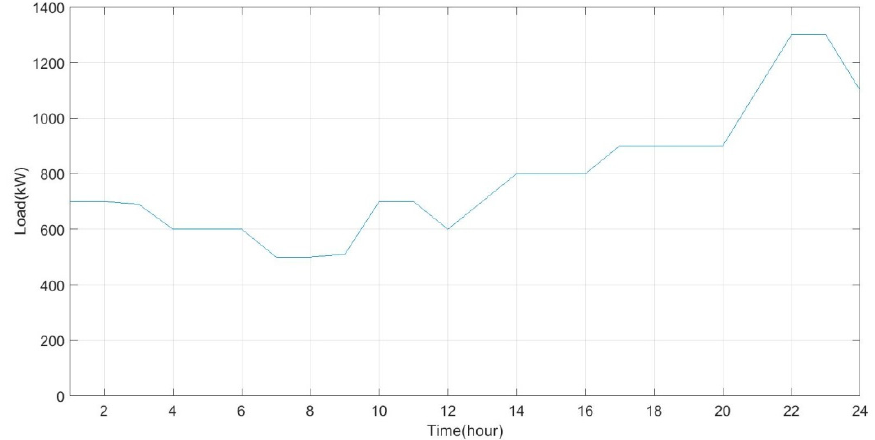
Figure 2. Expected load curve for scenario generation.